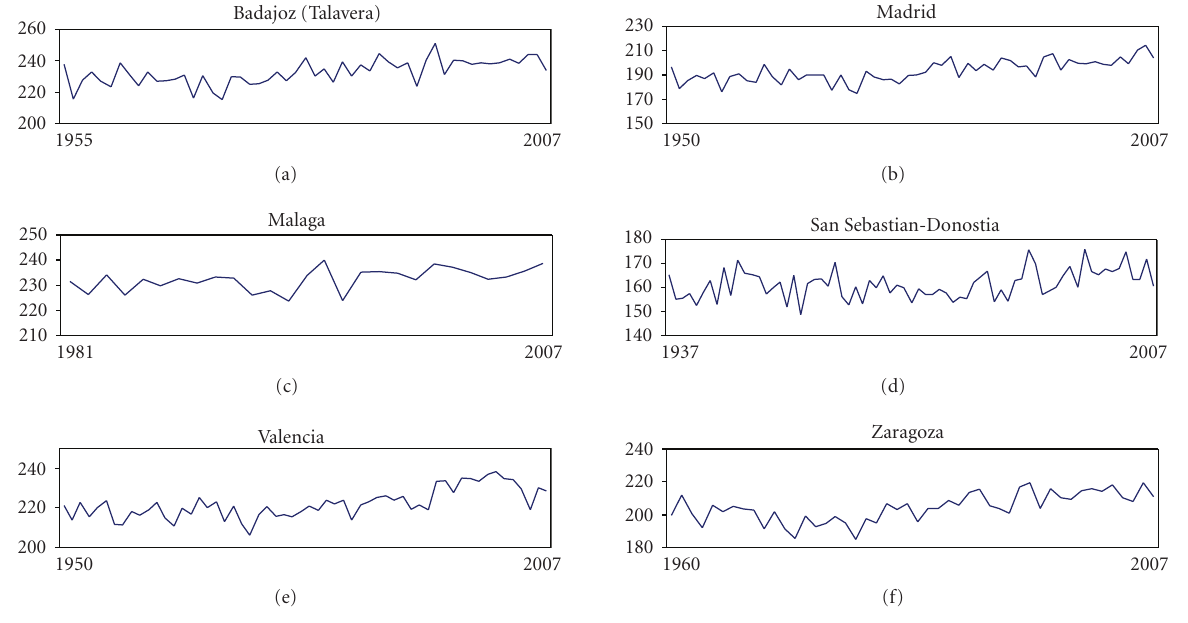
Figure 3: Annual mean maximum temperatures ( T max ) time series (in 0.1 ◦ C).